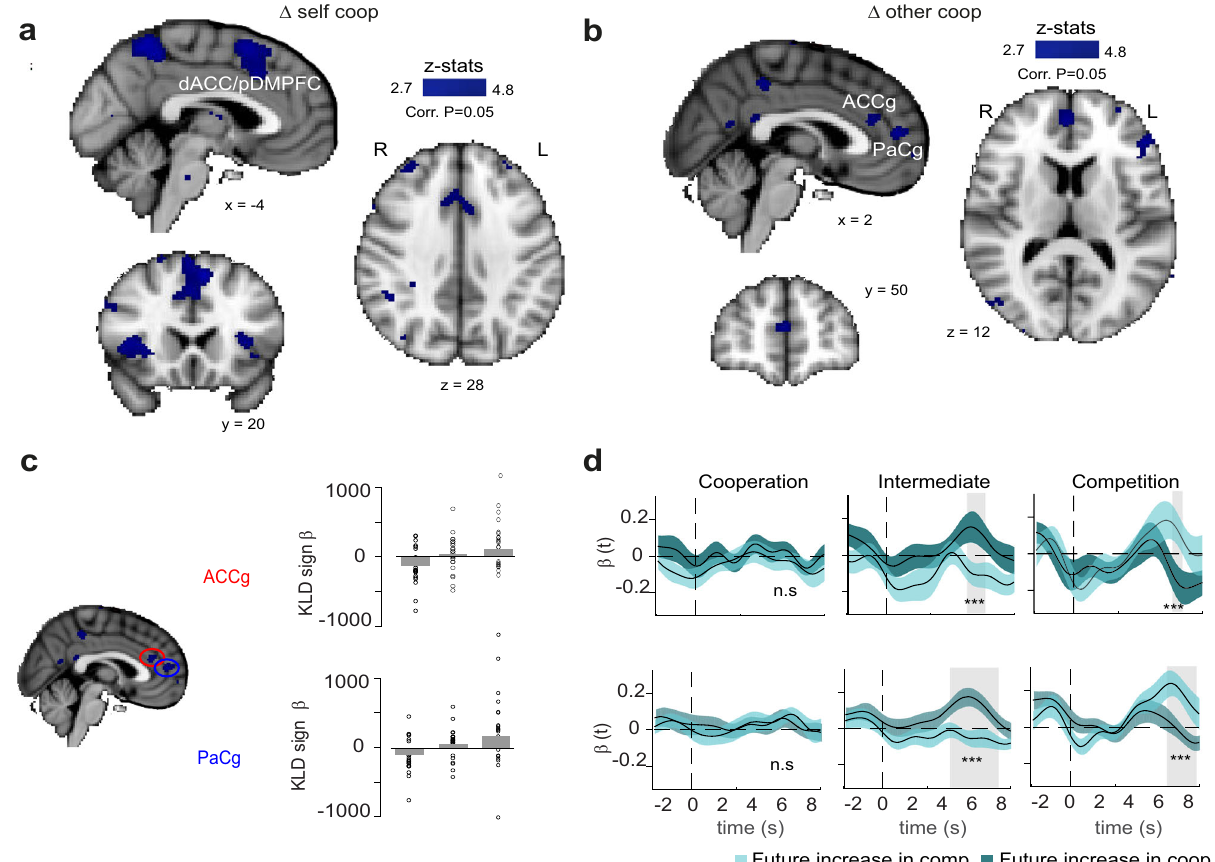
Fig. 5 | Social context modulated medial frontal, cingulate and paracingulate cortices encoding of changes in self and others cooperativeness. a This whole- brain analysisparametrically tested for voxelswhere the social contextmodulated howactivitycorrelatedwiththetrial-by-trialestimatesofP1 ’ schangesinthelevelof cooperation at the time P1 ’ s response. b This whole-brain analysis parametrically tested for voxels where the social context modulated how activity correlated with the trial-by-trial estimates of the sign of the social prediction error (P1 ’ s surprise